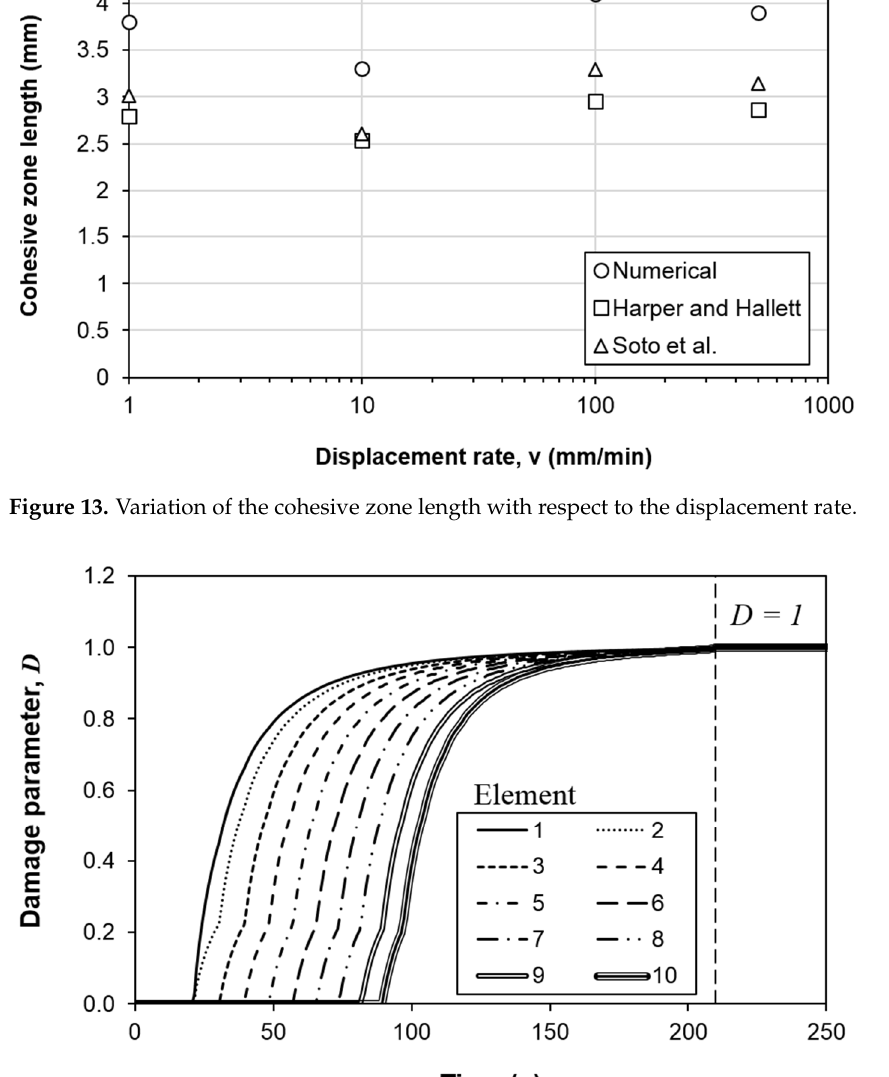
Figure 14. Temporal evolution of the damage parameter of the first ten elements from the initial crack tip.